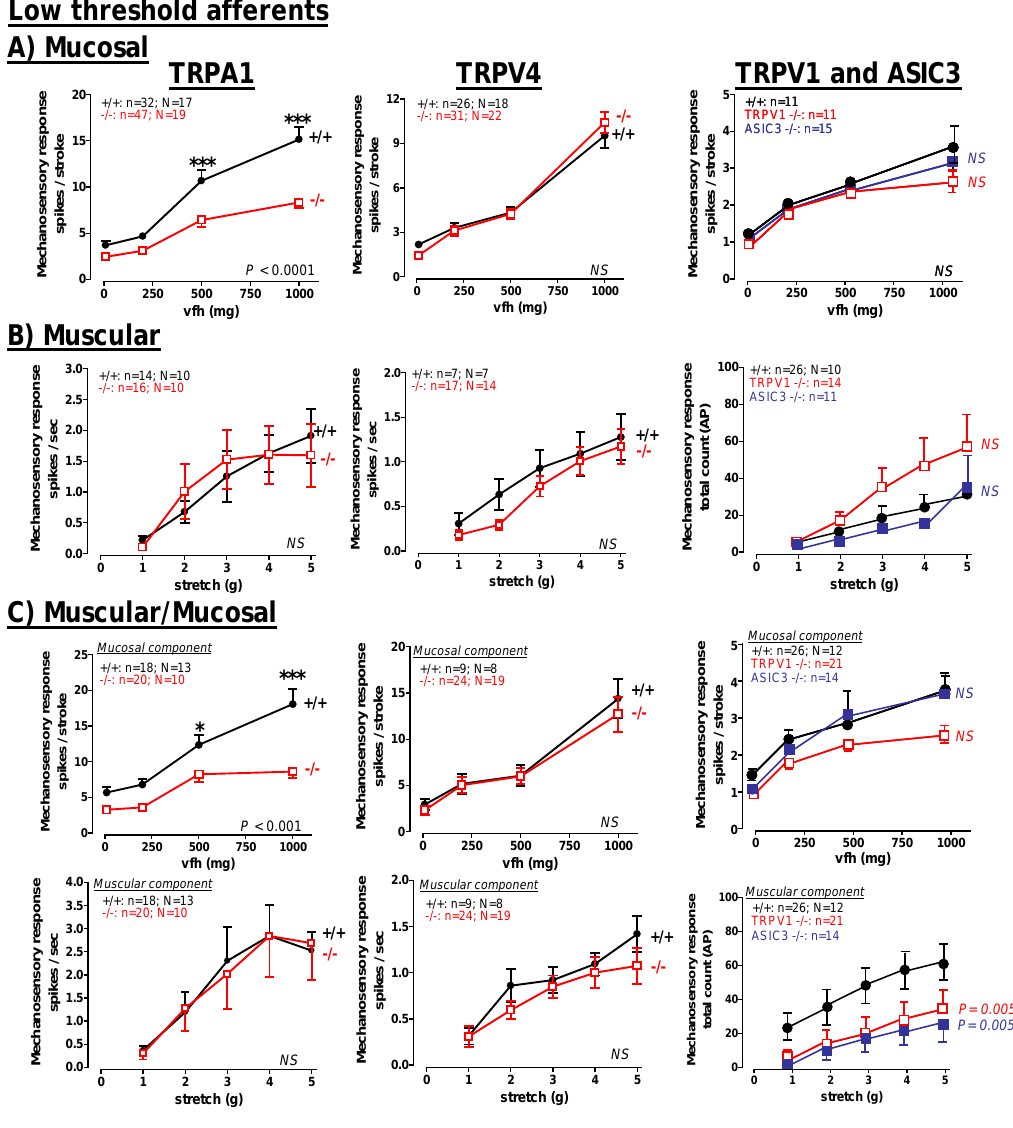
Figure 3. Limited contribution of TRPA1, TRPV4, TRPV1 and ASIC3 to low-threshold afferent mechanosensitivity. TRPA1 deletion only reduces the responsiveness of ( A ) mucosal and ( C ) muscular/mucosal afferents to mucosal stroking and does not affect the stretch responses of ( B ) muscular or ( C ) muscular/mucosal afferents. Deletion of TRPV4 has no effect at all on low threshold afferent mechanosensitivity ( A–C ). Deletion of TRPV1 or ASIC3 markedly reduces the stretch response of ( C ) muscular/mucosal